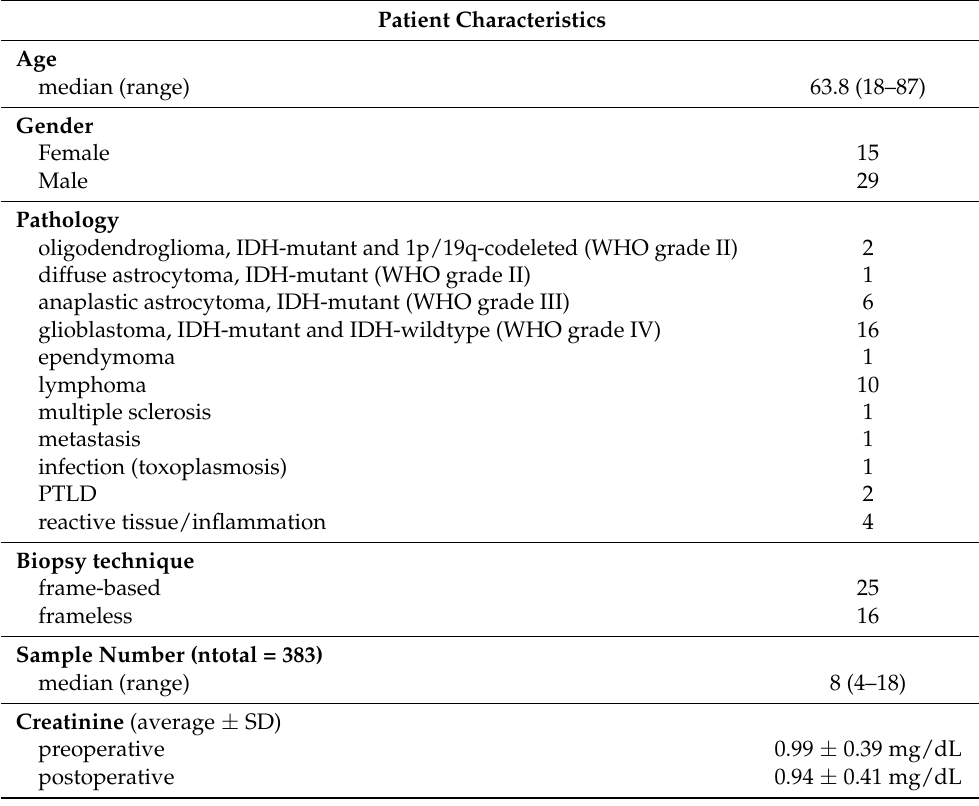
Table 1. Patient